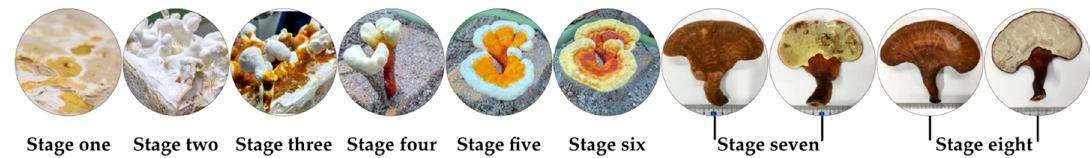
Figure 1. Experimental design of lingzhi ( Ganoderma lingzhi ) analysis harvested at eight developmental